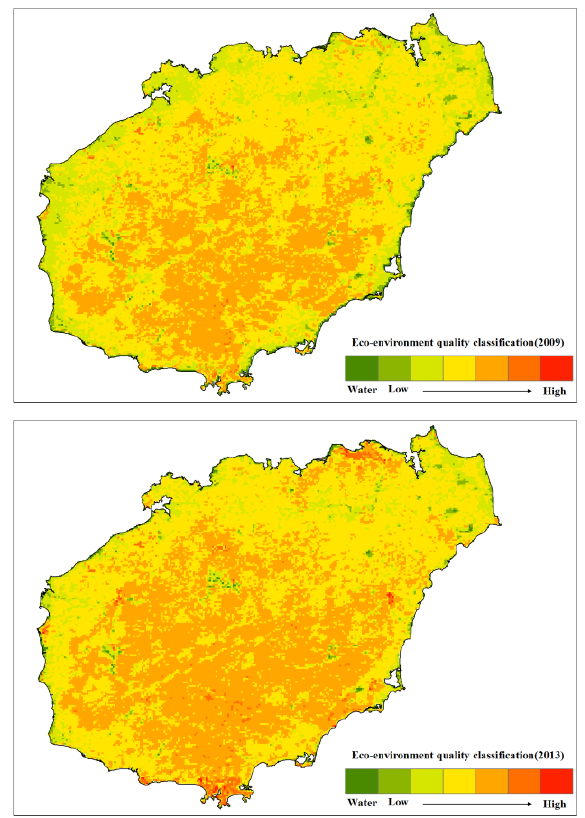
Figure1 The enhanced remote sensing ecological index images of study